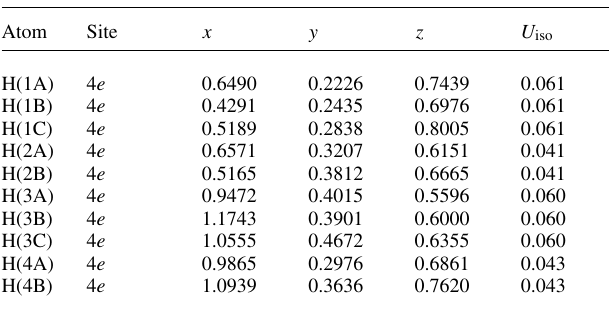
Table 2. Atomic coordinates and displacement parameters (in Å 2 )